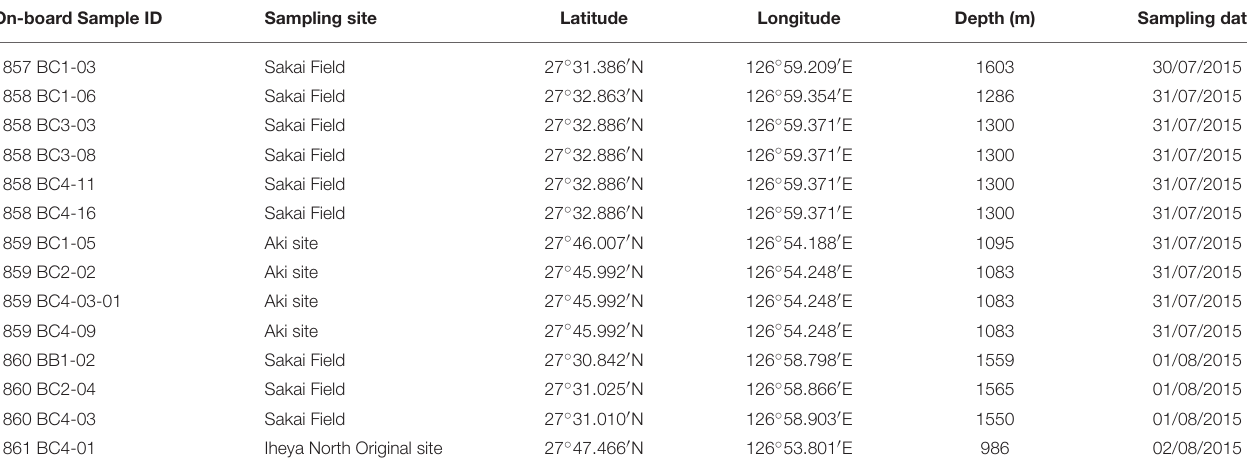
TABLE 1 | On-board sample ID and collecting data for samples used in the present study (often with mixed species). On-board Sample